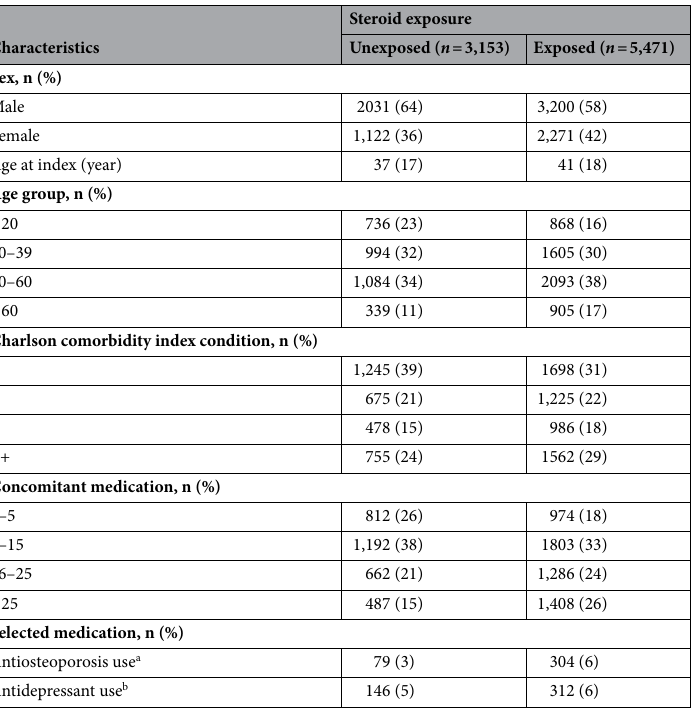
Table 1. Demographic characteristics of the study population stratified by systemic glucocorticoid exposure during the pre-index period (1 year before a renal biopsy). a Antiosteoporosis medications include alendronate, denosumab, fortical, ibandronate, miacalcin, raloxifene, risedronate, teriparatide, and zoledronic acid. b Antidepressants include selective serotonin reuptake inhibitors, selective serotonin, norepinephrine reuptake inhibitors, serotonin modulators, tricyclics, other norepinephrine reuptake inhibitors, and monoamine oxidase